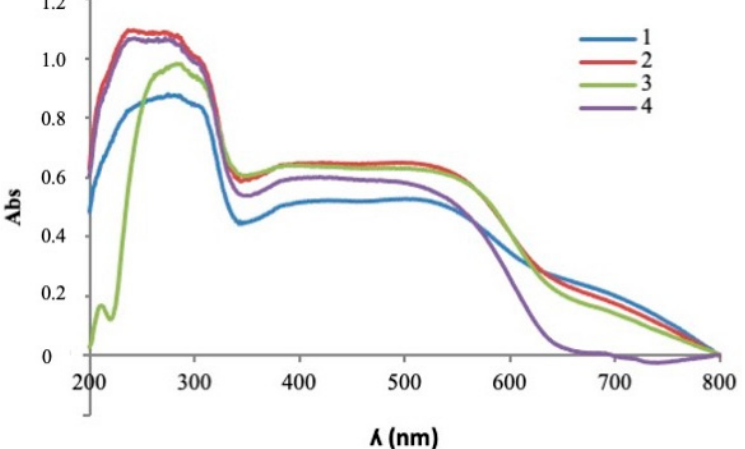
Figure 6. UV-Vis spectrophotometry of fired pigment 1500 °C/6 h with 5% w / w CaF 2 addition. 1. Y 0.99 AlCr 0.01 O 3 ; 2. Y 0.97 AlCr 0.03 O 3 ; 3. Y 0.95 AlCr 0.05 O 3 ; 4. Y 0.90 AlCr 0.10 O 3 .